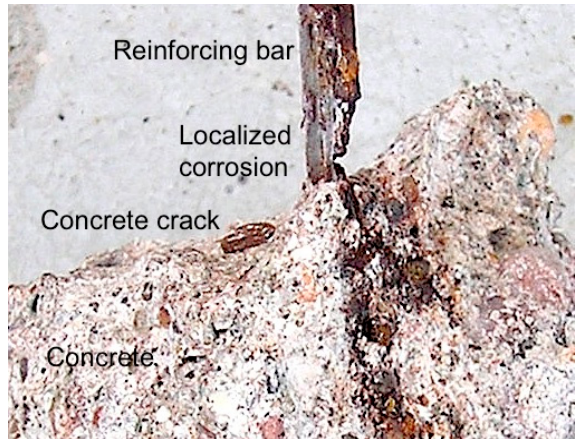
Figure 4. Highly localized corrosion of a reinforcing bar coincident with the location of hairline concrete crack through to the reinforcement from the outside of the concrete element—this is a disassembled picture with upper concrete removed. © R.E. Melchers 2020.